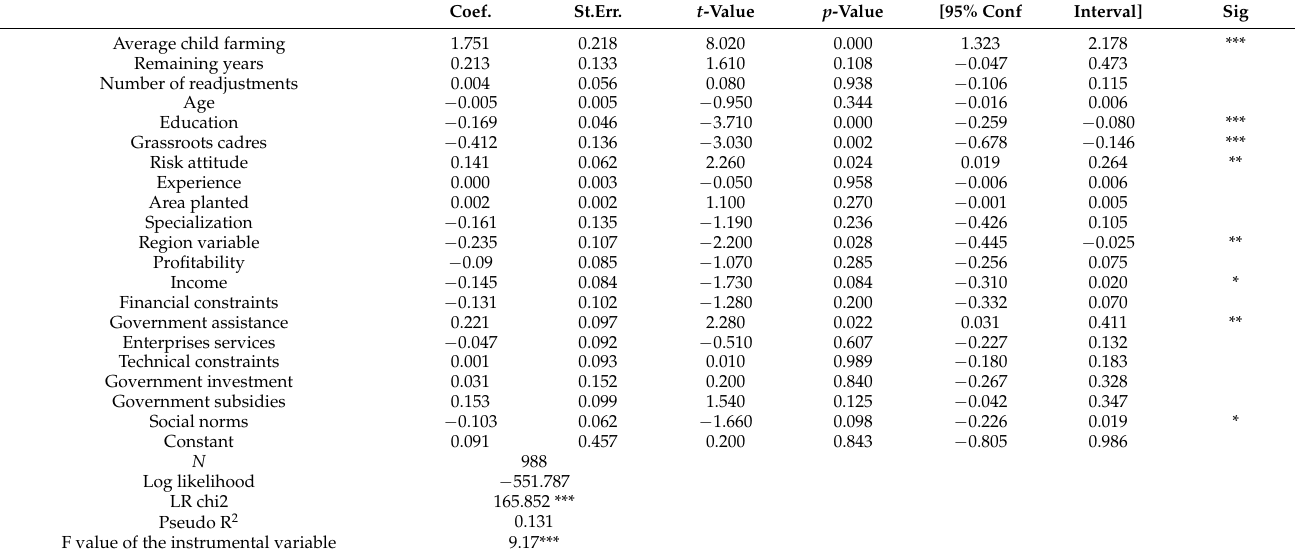
Table A1. Determinants of children